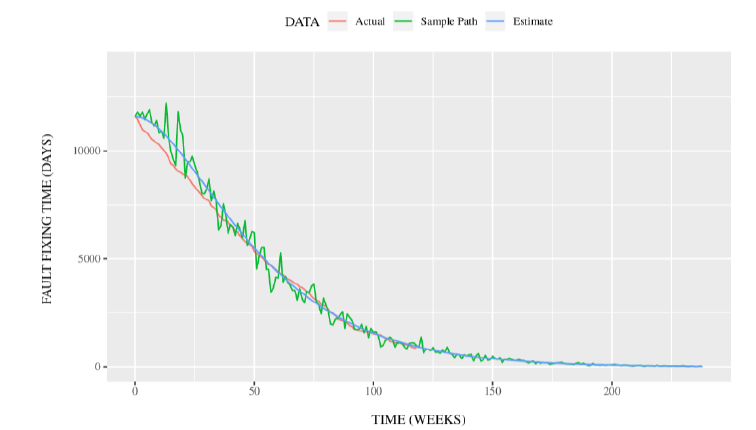
Figure 4. Remaining fault fixing time using delayed S-shaped model in Eqs. (12) and